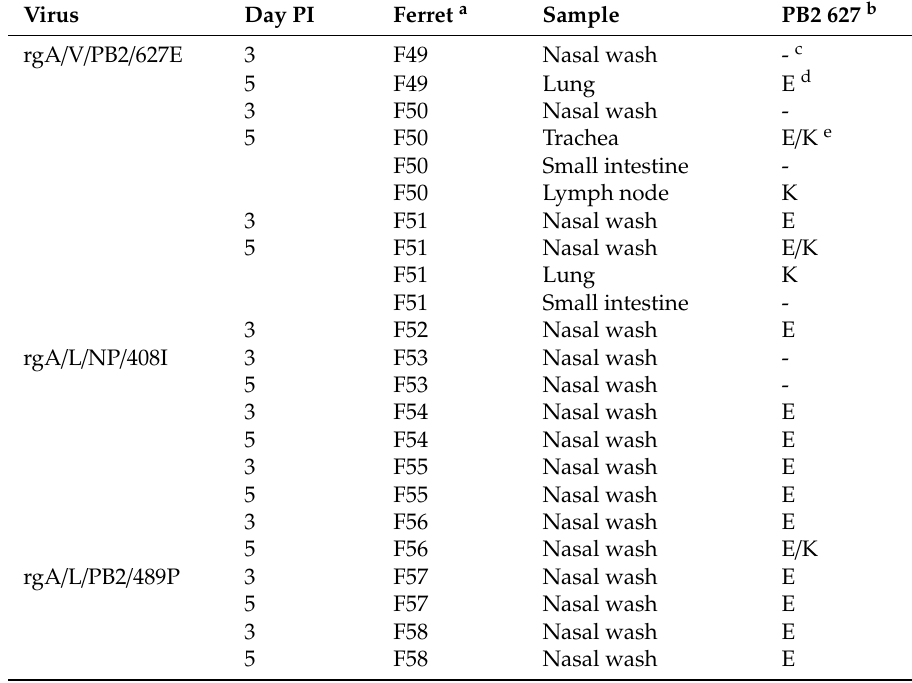
Table A4. PB2 627 sequencing following infection of ferrets with rg H5N1 viruses.